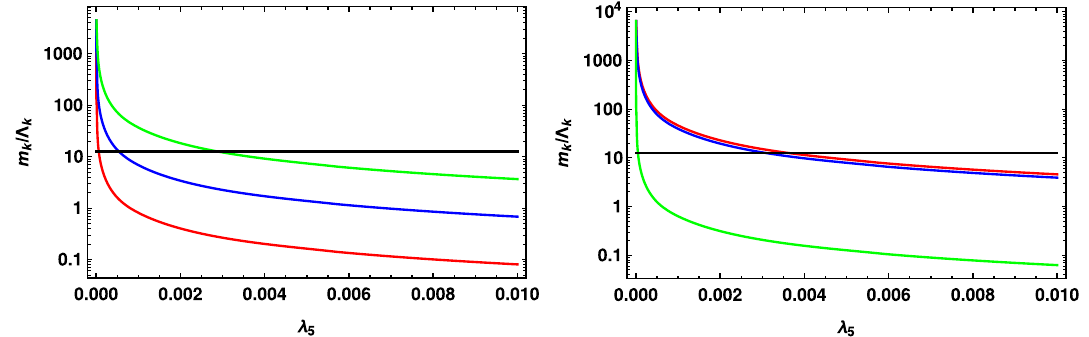
, m 2 (cid:12) and m 3 (cid:12) respectively. Horizontal line indicates the value 4 π . Left- and 1 2 3